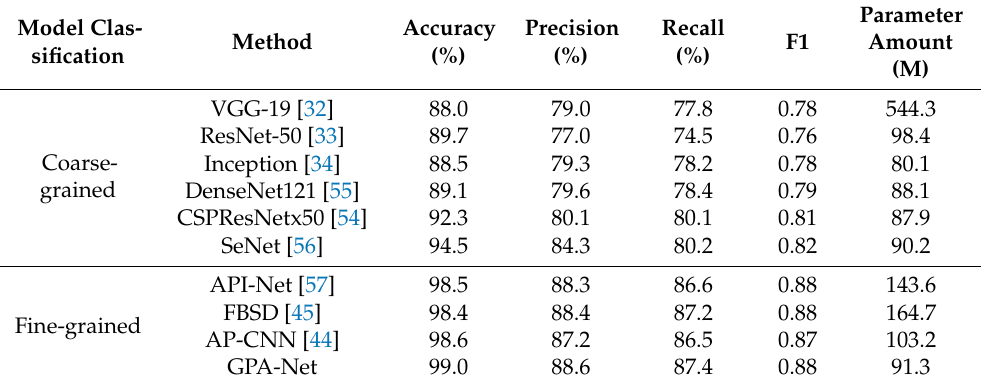
Table 1. Contrast performance on the Cassava